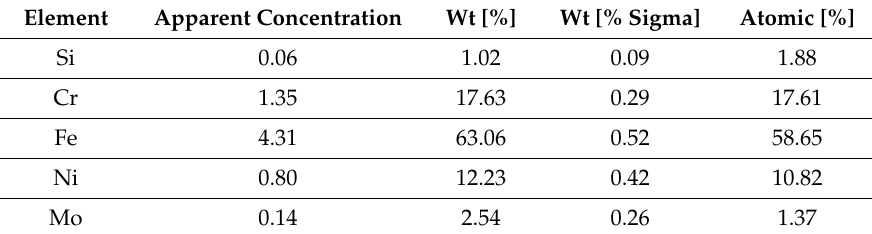
Table 2. 316L steel chemical composition after SEM-EDS